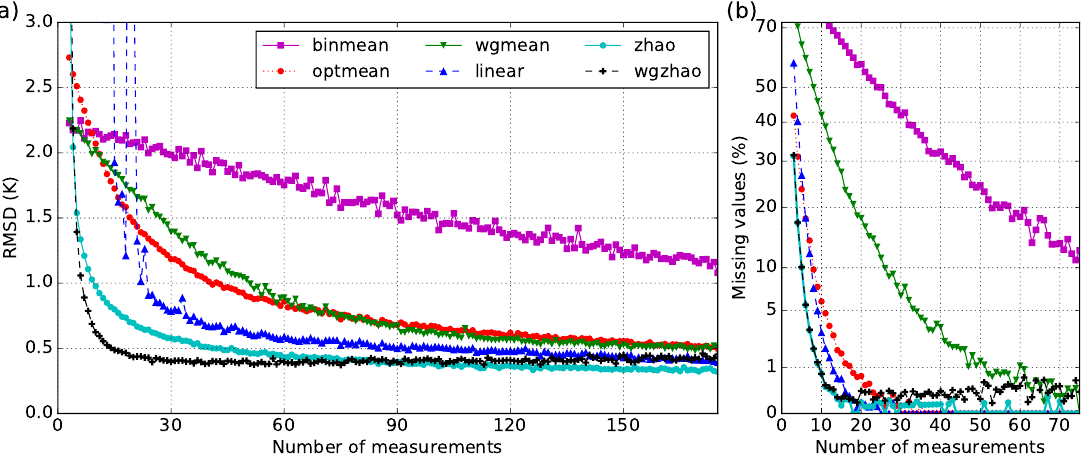
Figure 5. RMSD between modeled and fitted TBs ( a ) and amount of missing values ( b ) for the different fitting methods as a function of number of measurements n for θ 0 = 40 ◦ over a sea ice